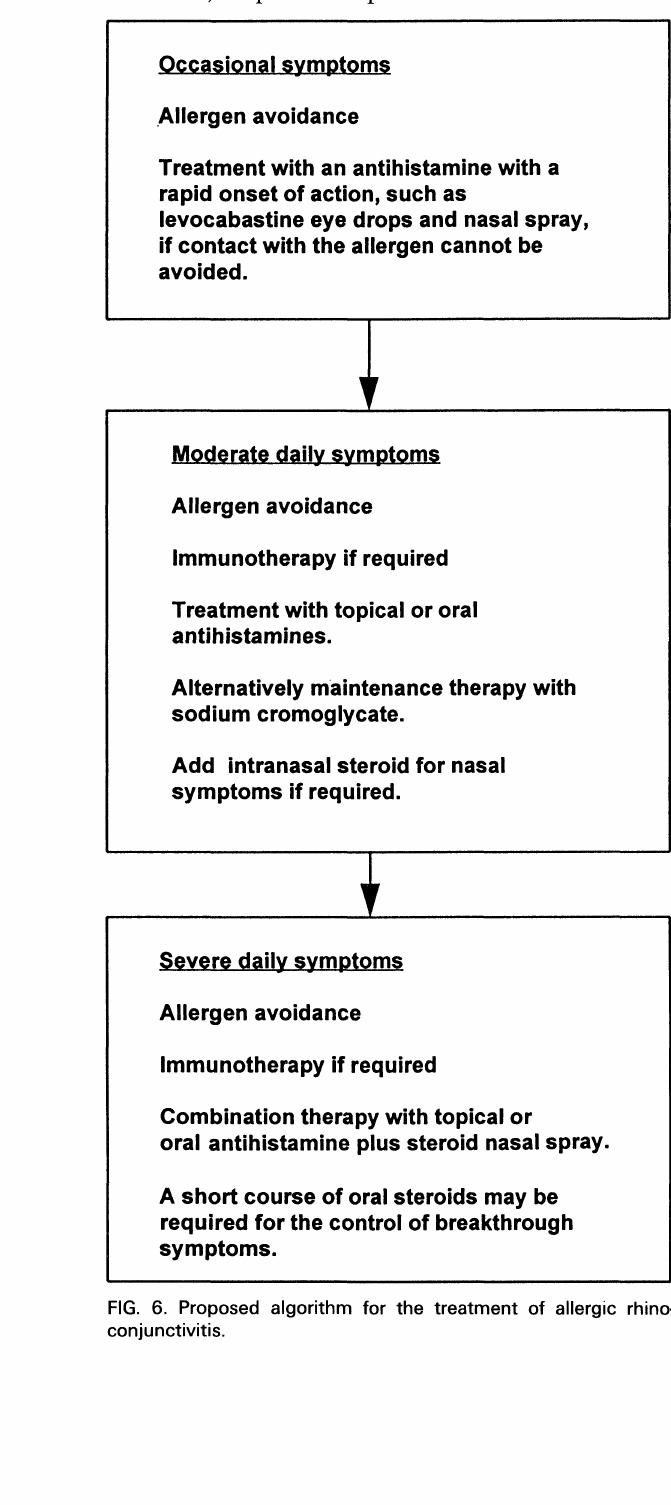
FIG. 6. Proposed algorithm for the treatment of allergic rhino-